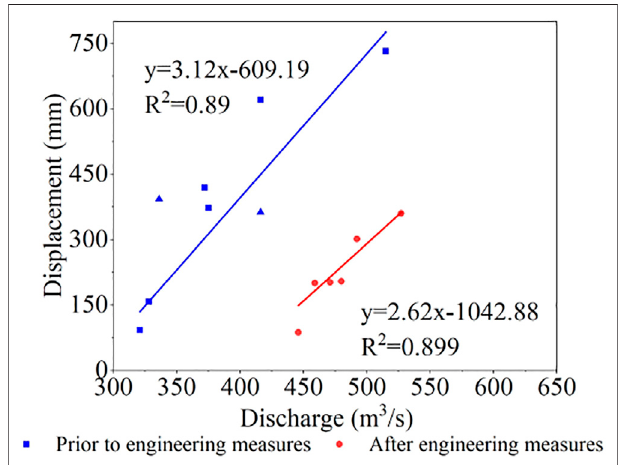
FIGURE 7 | Relationship between river discharge and horizontal displacement of the landslide before and after the engineering measures were implemented. Triangle data are from Zhao et al. (2021).